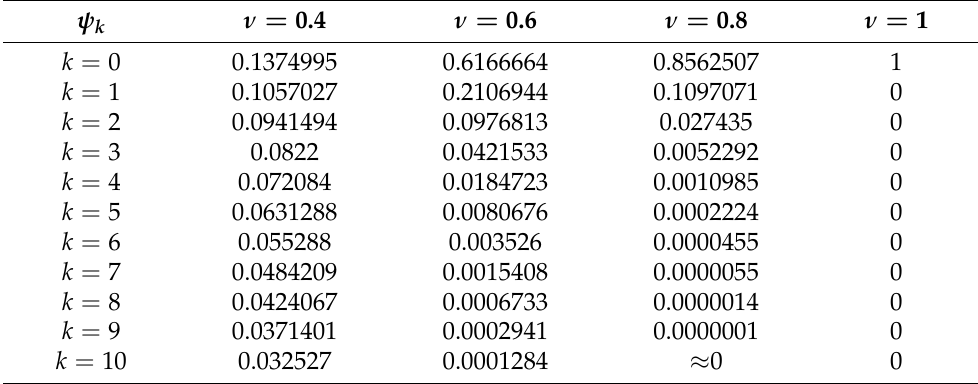
Table 1. The stationary distribution of the orbit size when a = 0.2, θ = 1, r = 0.3.